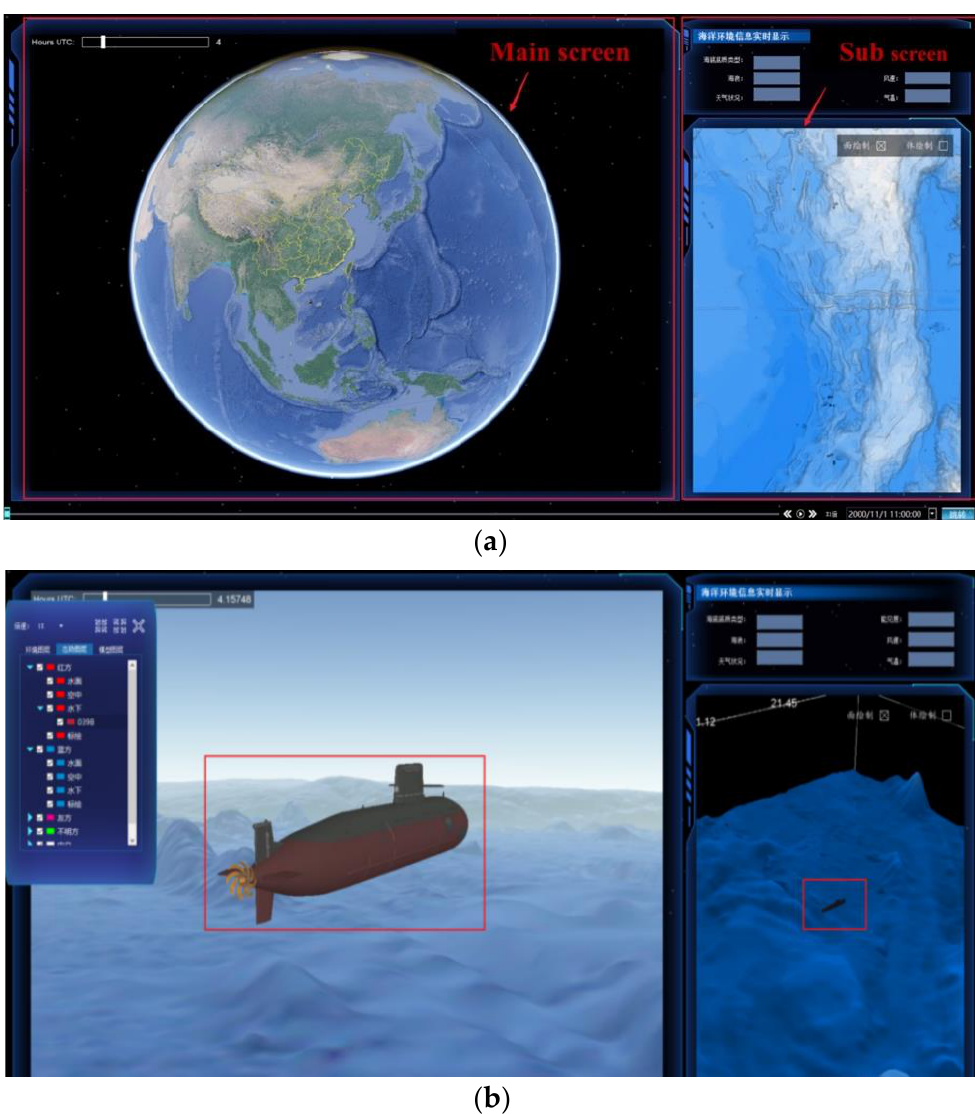
Figure 17. Multi-screen display effect. ( a ) is the overview of the multi-screen display, ( b ) is the multi-screen display in the submarine scene .